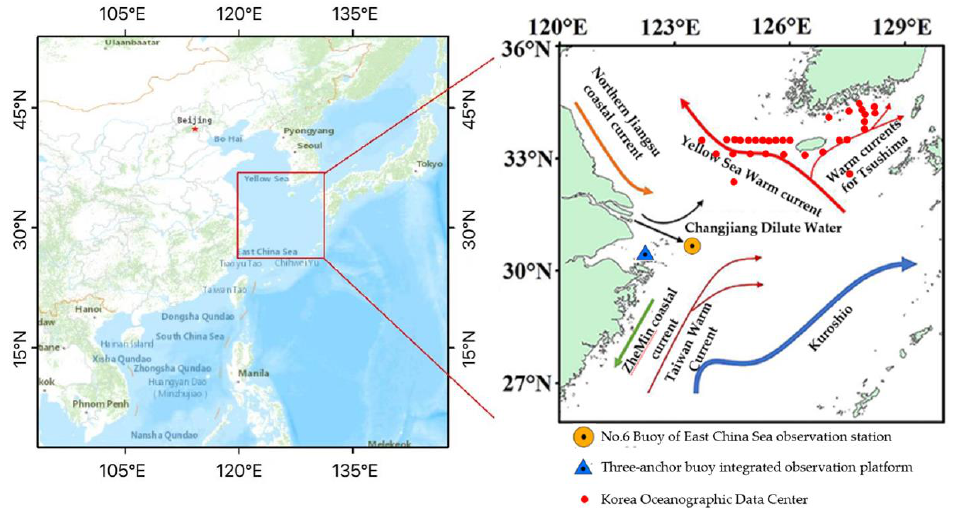
Figure 1. Sketch map of Geographical location, main currents and the stations collecting the in-situ data of the study area.